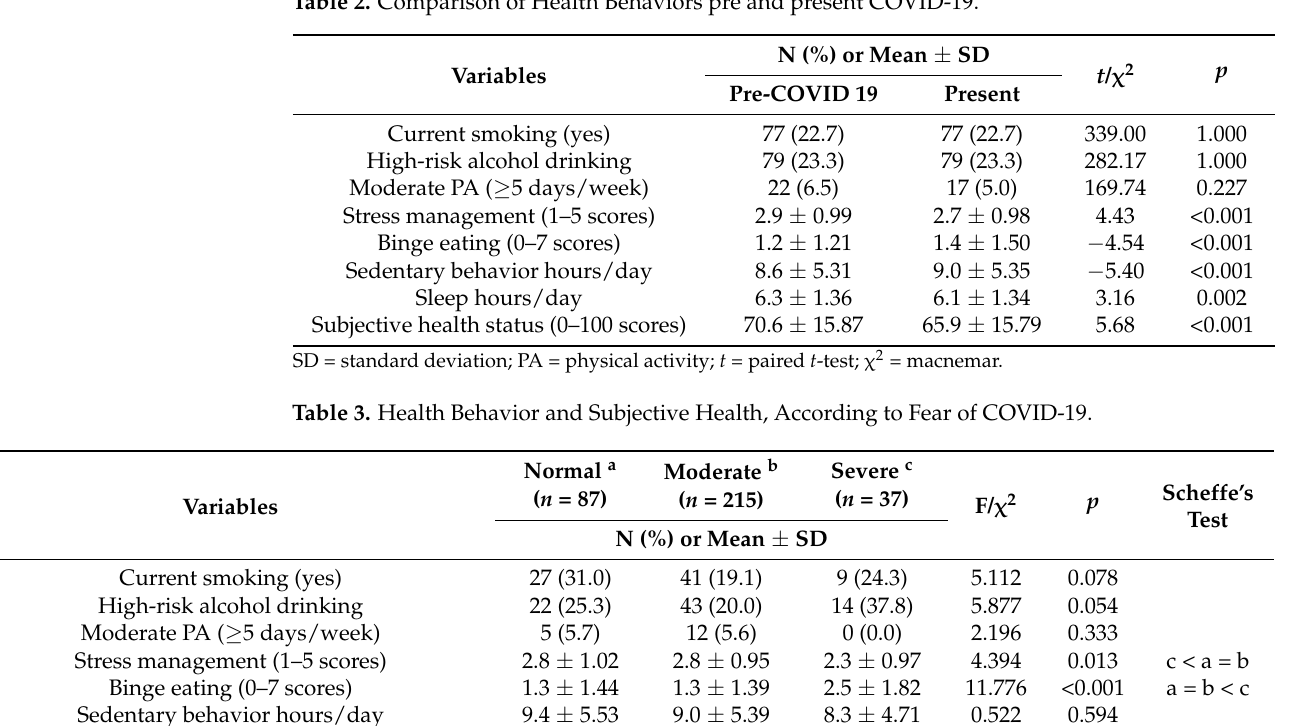
Table 2. Comparison of Health Behaviors pre and present COVID-19.